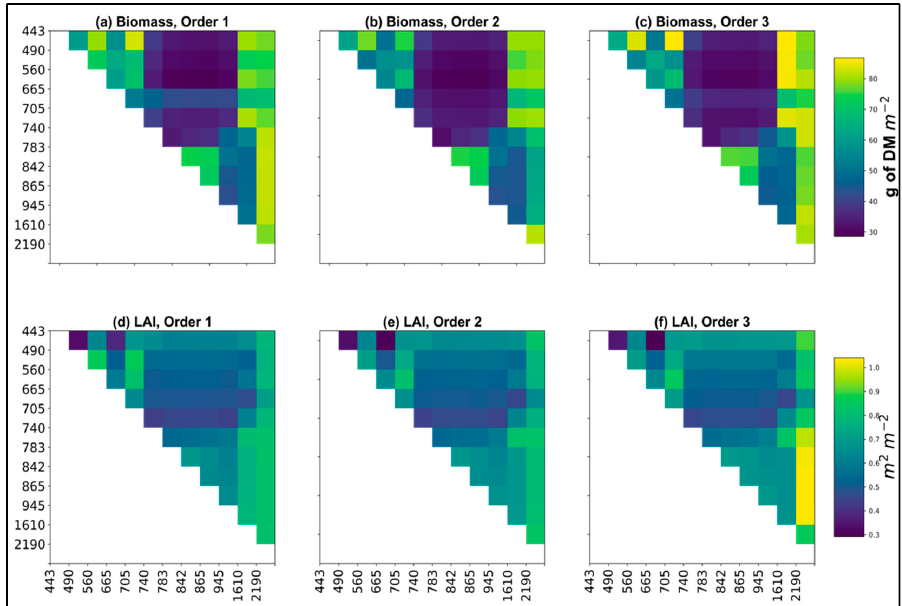
Figure 1. Two-dimensional matrix plot showing mean square errors ( MSE s) obtained for models built using all possible Sentinel-2-based two-band normalised difference indices (NDIs) for ( a – c ) biomass (39 samples) and ( d − f ) leaf area index (LAI, 39 samples).